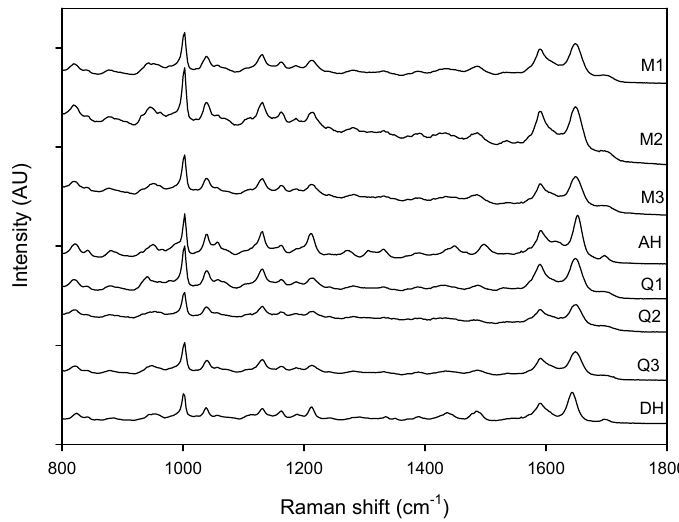
Figure 3. Raman spectra of milled samples (M1, M2 and M3), quench cooled samples (Q1, Q2 and Q3), crystalline anhydrate (AH) and crystalline dihydrate (DH).